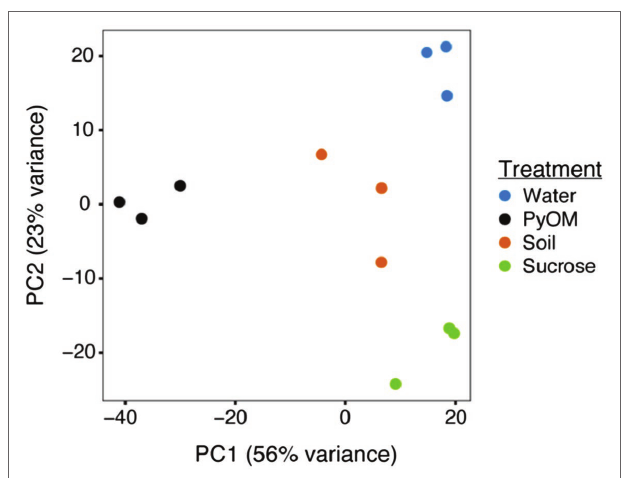
FIGURE 2 | Pyrolyzed substrates induce expression of distinct sets of genes in P. domesticum . Principal Component Analysis (PCA) plot illustrating the variation between each sample transcriptome (normalized expression values). Prior to RNA extraction, P. domesticum DOB7353 was grown in triplicate on four different agar media